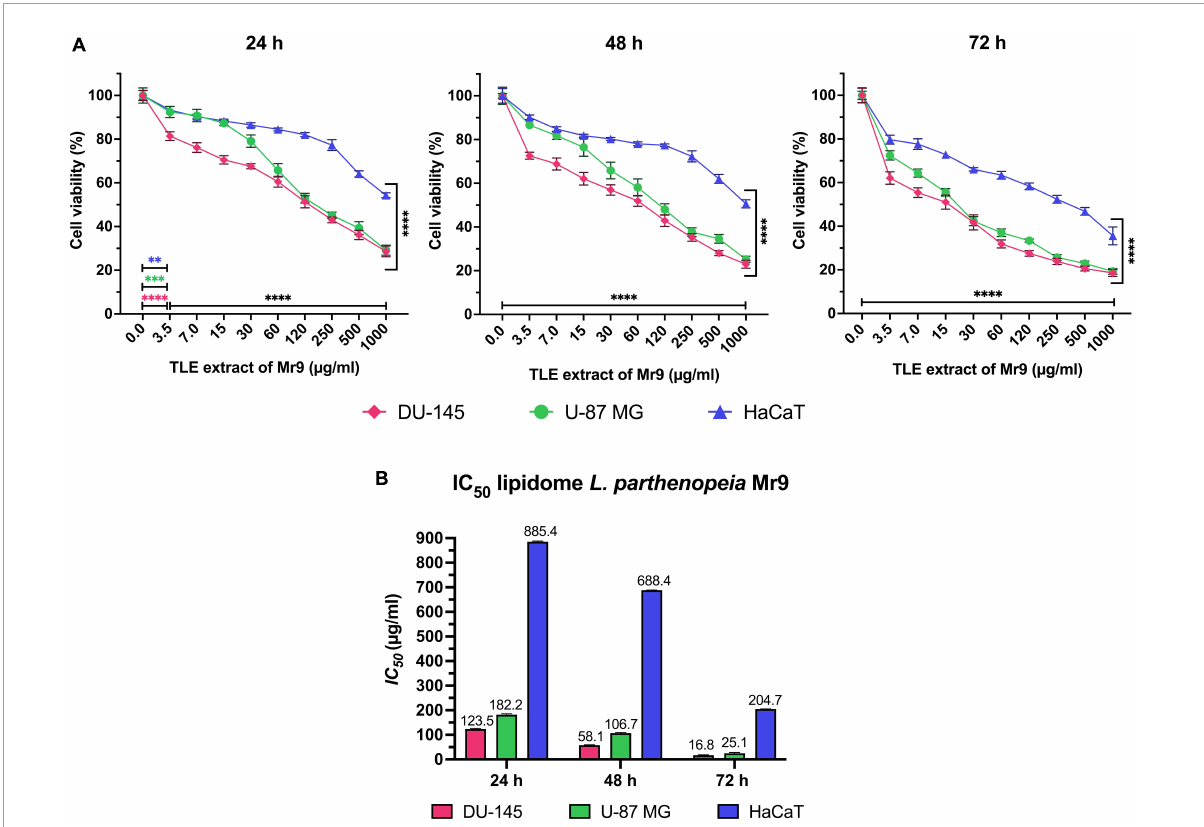
FIGURE5 (A) Effect of total lipid extract from Leeuwenhoekiella parthenopeia Mr9 T cell extract in the cell viability of DU-145, U-87 MG, and HaCaT after 24, 48, and 72 h of stimulation with gradual doses. Untreated cells (0 µ g/mL) were used as control and indicate cells treated with dimethyl sulfoxide (DMSO) without L. parthenopeia Mr9 T extract. Control corresponds to 100% of viability. The histograms represent the mean ± SD of three independent experiments performed in triplicate ( n = 9), normalized to untreated control cells. Statistical analysis: p -value: 0.002 ( ∗∗ ), 0.0002 ( ∗∗∗ ), and < 0.0001 ( ∗∗∗∗ ) compared to the control. (B) IC 50 inhibitory concentrations of the total lipid extract (TLE) required to inhibit DU-145, U-87 MG, and HaCaT after 24, 48, and 72 h of